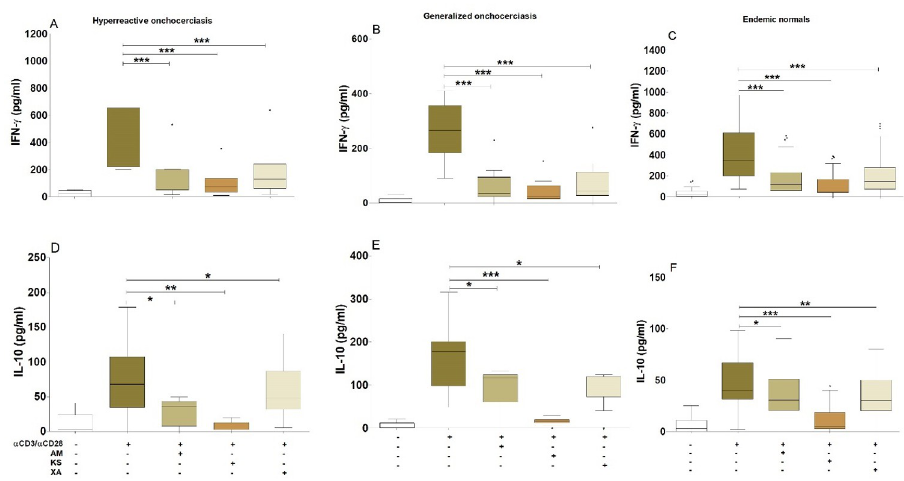
Fig 4. Inhibition of IFN- γ and IL-10 induction by the hydro-ethanolic extracts of Aframomum melegueta , Khaya senegalensis or Xylopia aethiopica . PBMCs (2x105 cells) isolated from EN (n = 13), GEO (n = 15) and HO (n = 6) individuals were activated with α CD3 (12.5 μ g /well) / α CD28 (2.5 μ g / well) in the presence or absence of Aframomum melegueta (AM), Khaya senegalensis (KS) or Xylopia aethiopica (XA) extracts (200 μ g / mL). Box whiskers (tukey) with outliers show levels of IFN- γ (A, B and C) and IL-10 (D, E and F) after co-culture with α CD3 / α CD28 in presence or absence of AM, KS or XA. Asterisks show statistical differences (Mann-Whitney-U test) between the groups indicated by the brackets ( � p < 0.05, �� p < 0.01, ��� p < 0.001).